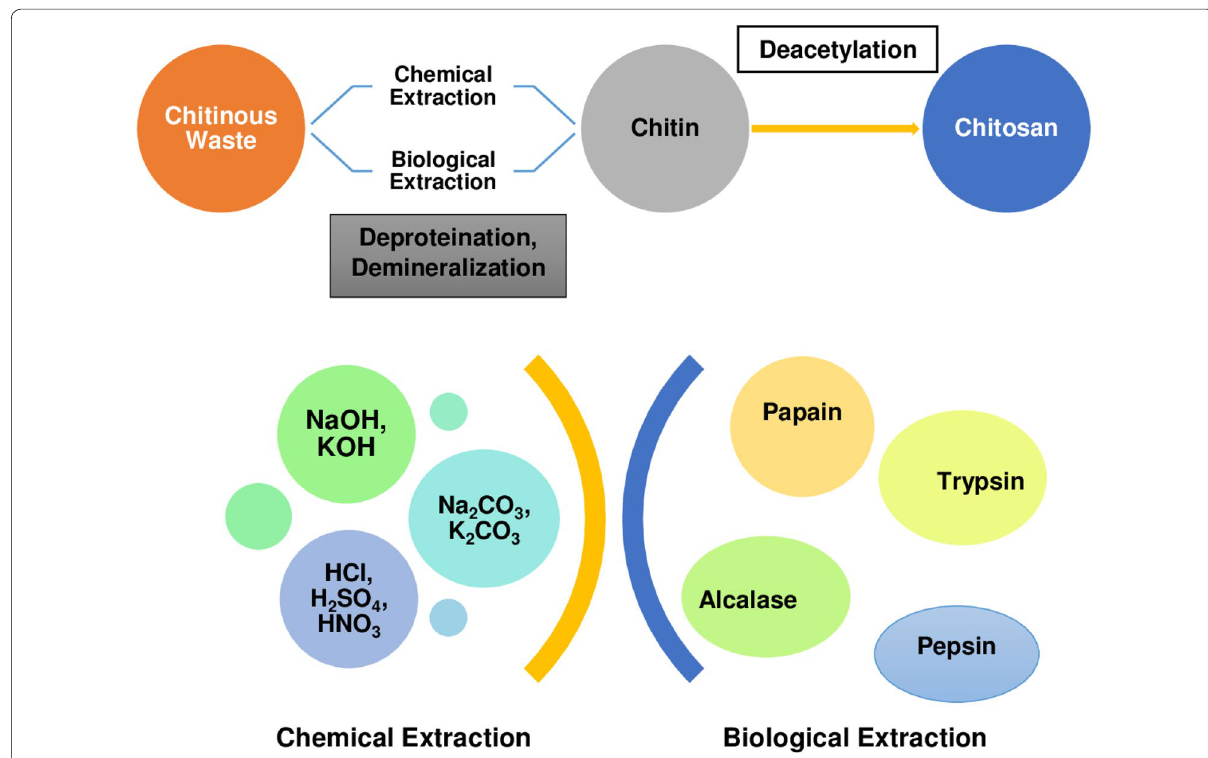
Fig. 4 Chitin and chitosan extraction from chitinous marine